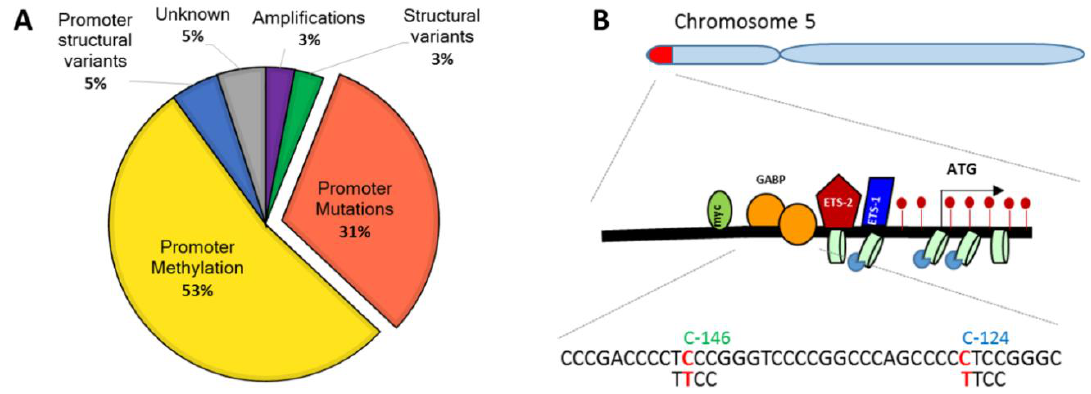
Figure 1. Mechanisms of telomerase reverse transcriptase ( TERT ) reactivation in cancer and TERT promoter ( TERTp ) mutations. ( A ) Different mechanisms of TERT reactivation in cancer according to Reference [10]. ( B ) Localization of TERTp mutations on Chromosome 5.